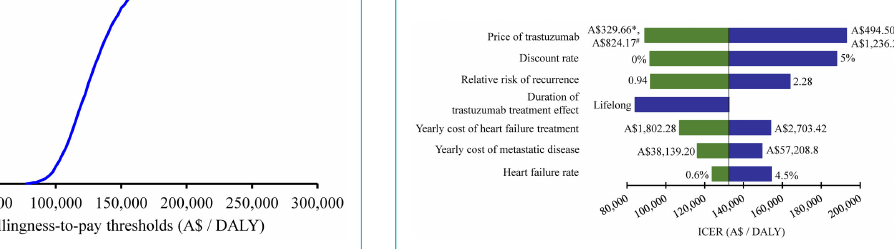
Figure 5: Tornado diagram of univariate sensitivity analysis. *Cost of a 60 mg vial; #cost of a 150 mg vial. DALY = disability-adjusted life-year; ICER = incremental cost-effectiveness ratio. Blue bars in- dicate high value of variable, green bars indicate low value of vari-